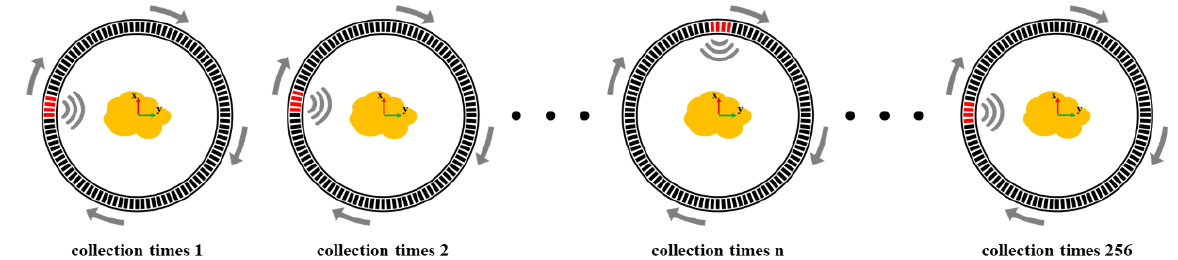
Figure 3. Schematic of the control mode of the receiving elements and the transmitting elements based on the M-SAF. The elements of the sub-aperture move an element clockwise in the ring array, as shown in the red arrays. M-SAF: multi-element synthetic aperture focusing.